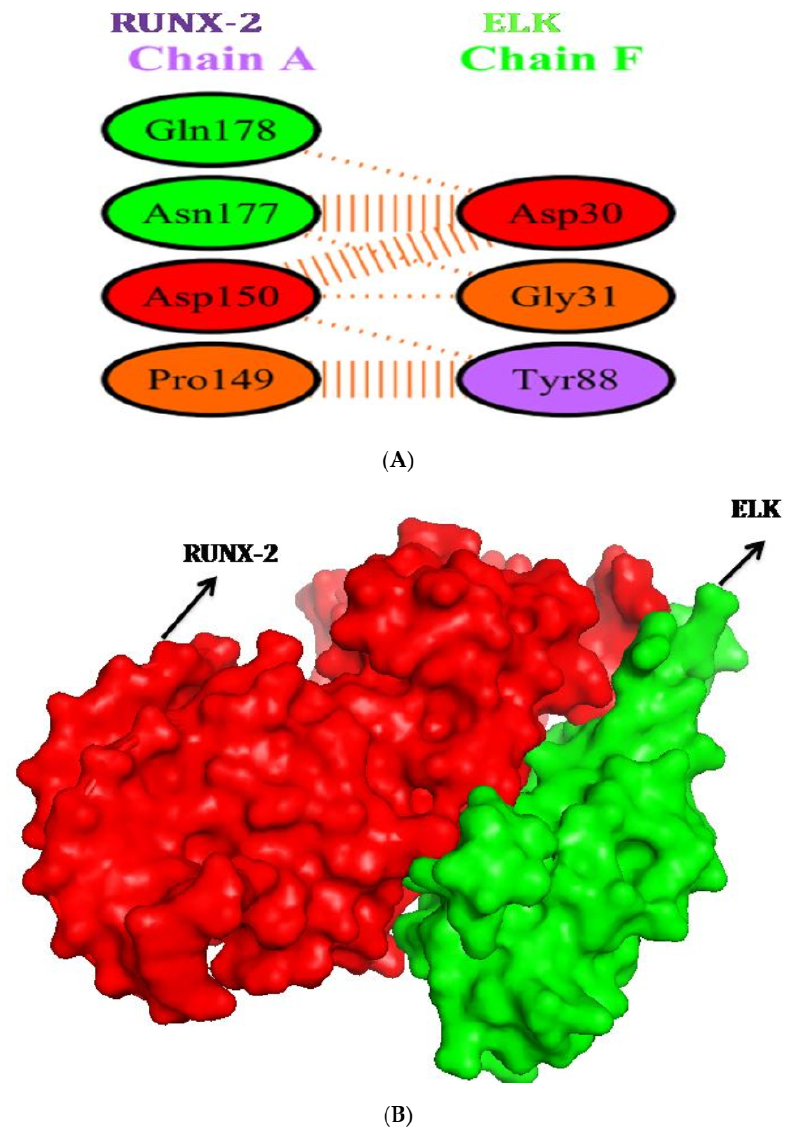
Figure 8. ( A , B ): Protein–protein interaction of Runx2 with